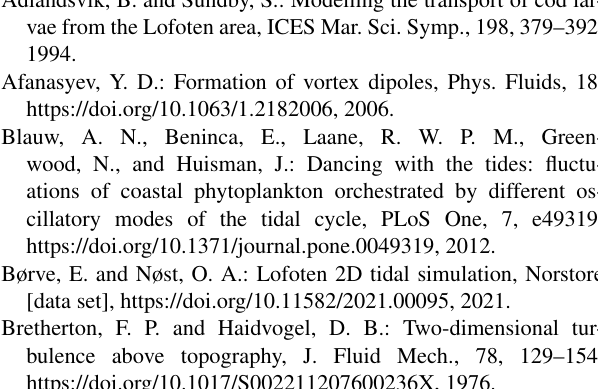
Figure A2. Vorticity flux averaged over an integral number of tidal period as a function of time, for the solution of Eq. (A6). Positive values indicate a vorticity flux towards deep waters. Panels (a) and (b) show results for R = 0 . 003ms − 1 and R = 0 . 0015ms − 1 , re- spectively, starting from five different initial vortices ξ 0 . The other parameters are as in Fig. A1.